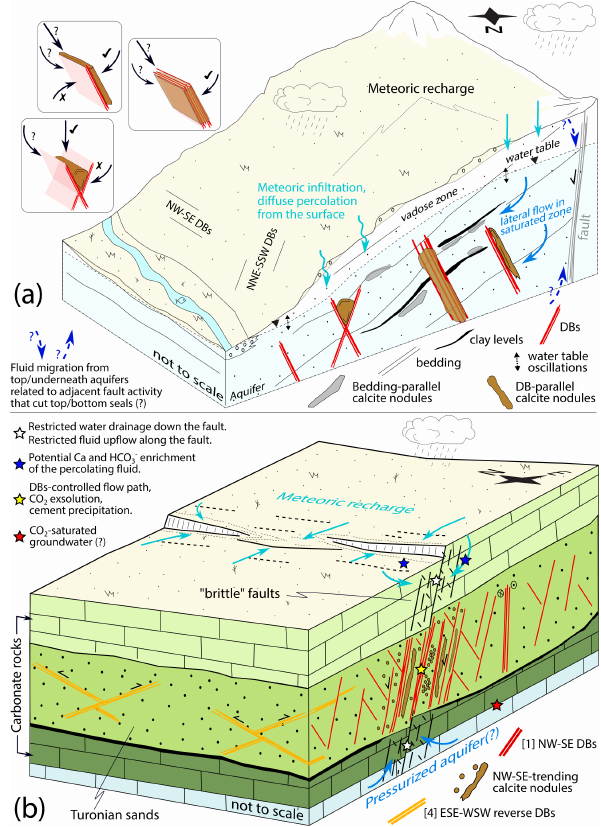
Figure 13. Generalized conceptual model for calcite nodule pre- cipitation in the two study areas: (a) Loiano and (b) Bollène. See text (Sect. 7.3) for details. The inset sketches in (a) show a possi- ble paleo-fluid flow direction at the time of calcite precipitation for different DB–nodule